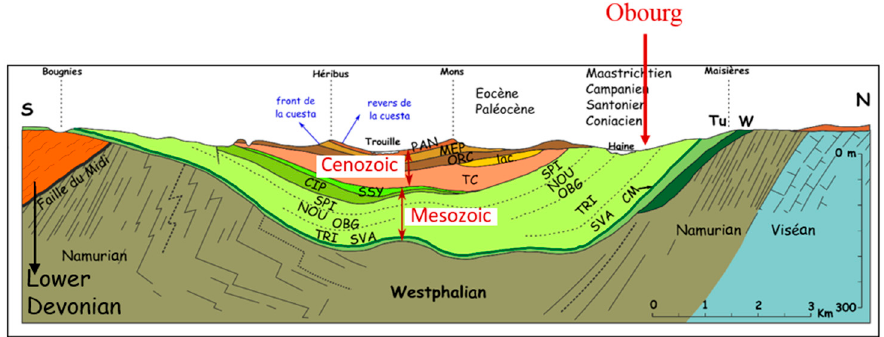
Figure 2. Modified south–north geological section of the Mons Basin and projection of the Obourg quarry location [21].